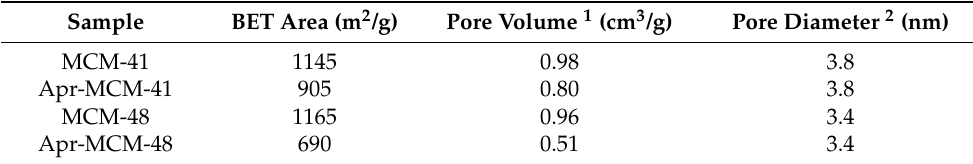
Table 3. Pore properties measured for the pristine and drug-loaded MSN particles.